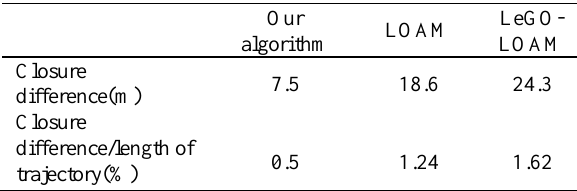
Table 2. Closure difference for Site 1